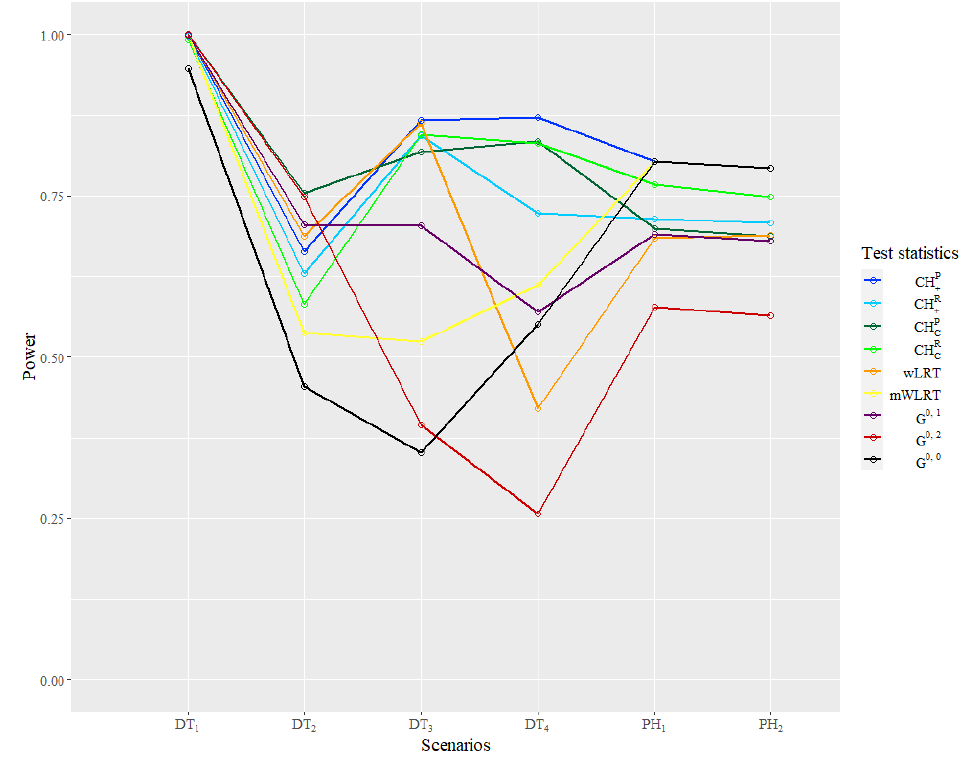
Figure 5. Empirical power of tests in simple